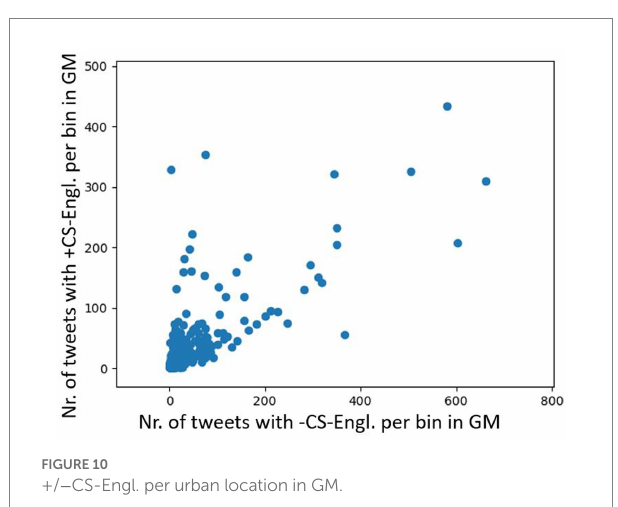
FIGURE 11 Base-10 logarithm on +/ − CS per bin in